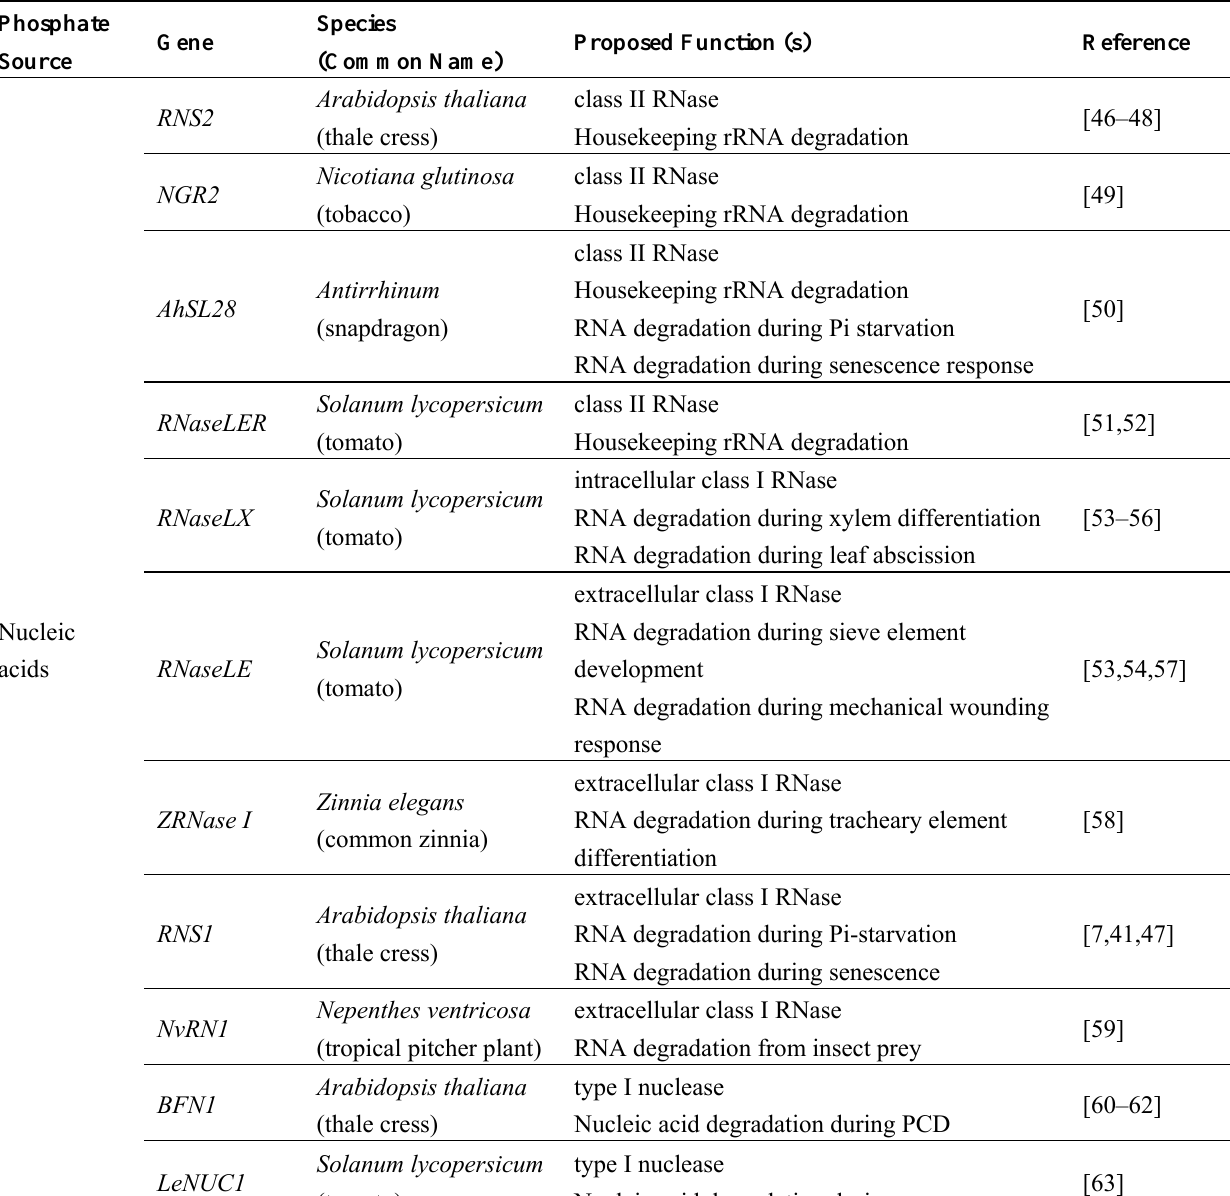
Table 2. Genes involved in Pi scavenging during nutritional Pi deprivation and/or leaf